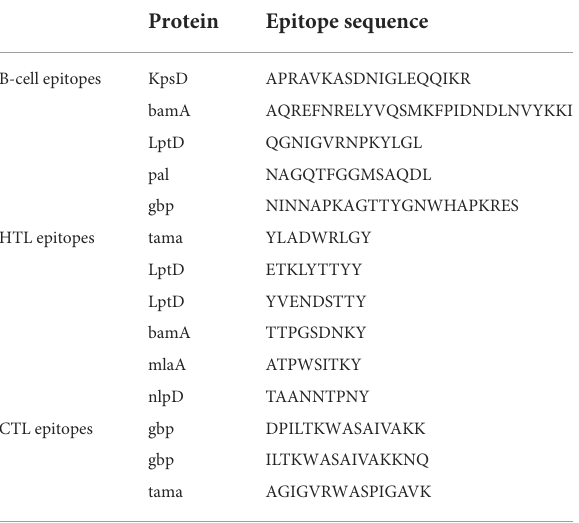
TABLE 2 Predicted B-cell, CTL, and HTL epitopes for the design of the vaccine protein. Protein Epitope sequence